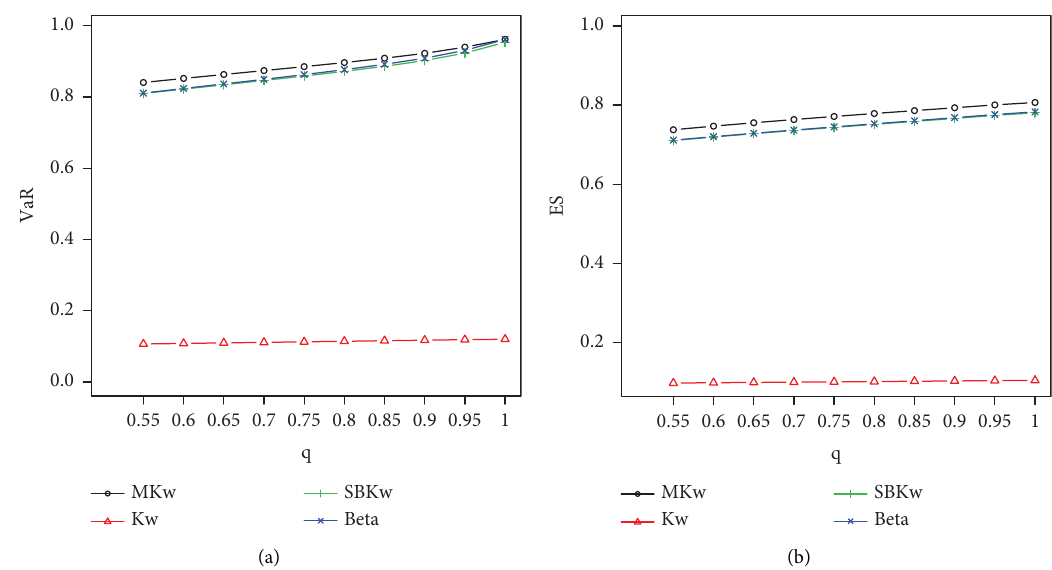
Figure 13: Plot of (a) VaR and (b) ES of MKw and Kw model data